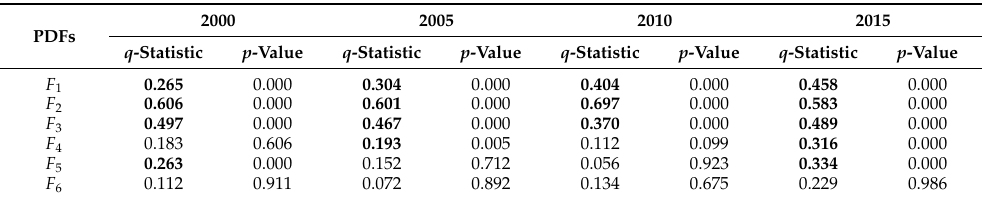
Table 7. Factor detection results between the CMPI and PDFs in China’s counties. F 1 is economic capital deprivation; F 2 is geographical capital deprivation; F 3 is natural resource endowment capital deprivation; F 4 is agricultural capital deprivation; F 5 is human and labor capital deprivation; F 6 is compulsory education capital